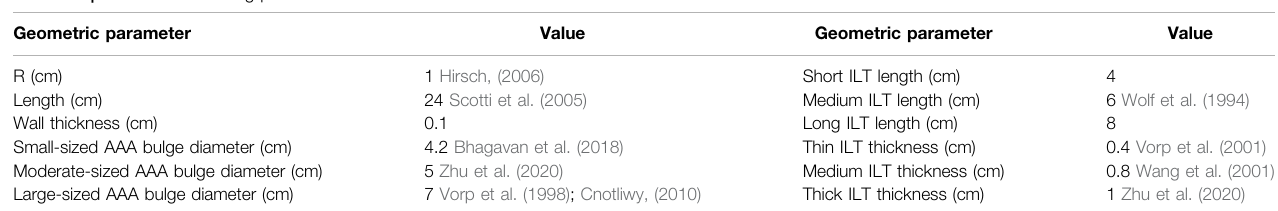
TABLE 1 | Geometric modelling parameters and their values in idealized lesions. Geometric